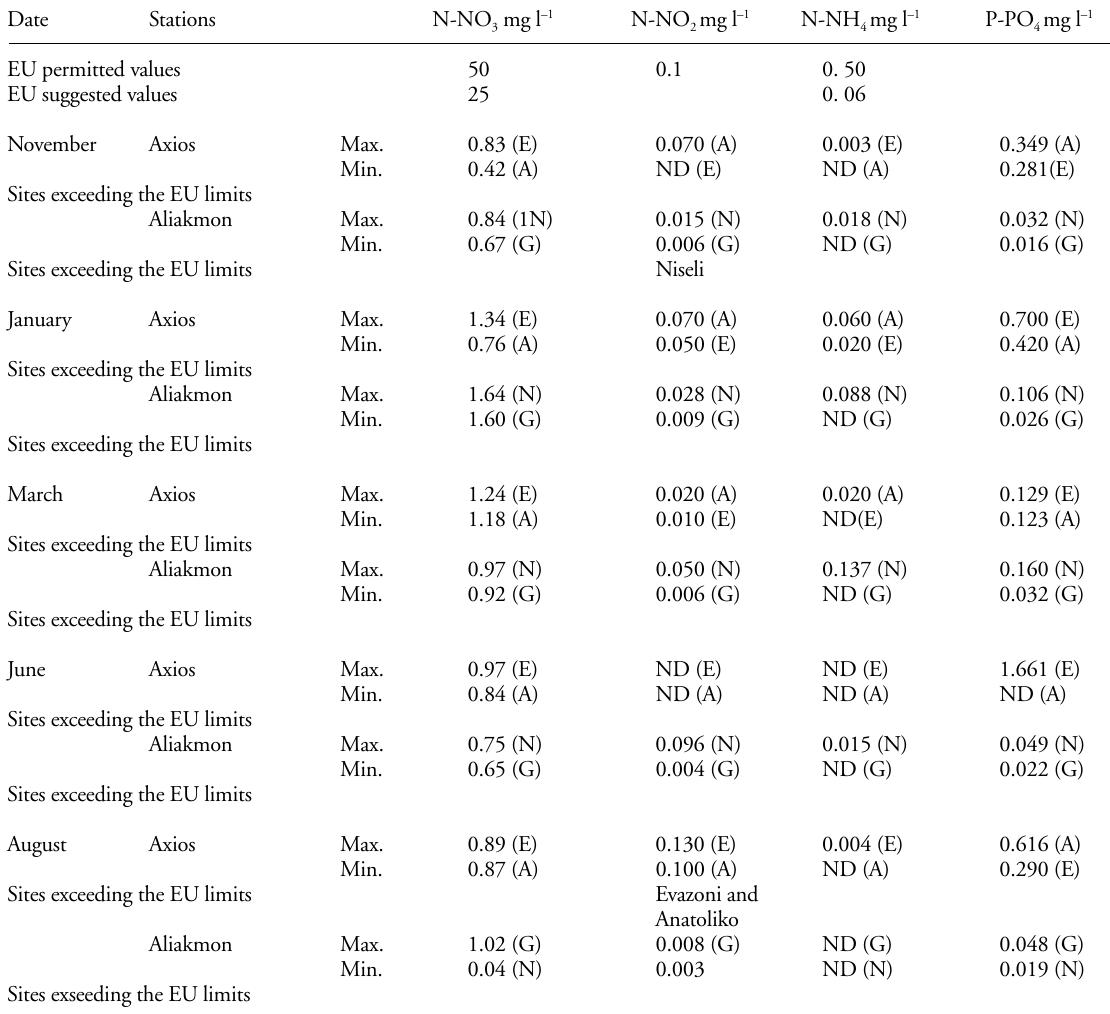
Table 8. Nutrients at Axios and Aliakmon river (ND: not